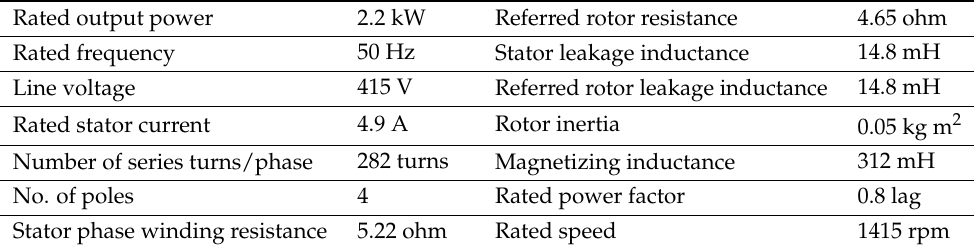
Table 2. Equivalent Circuit Parameters of the Motor under